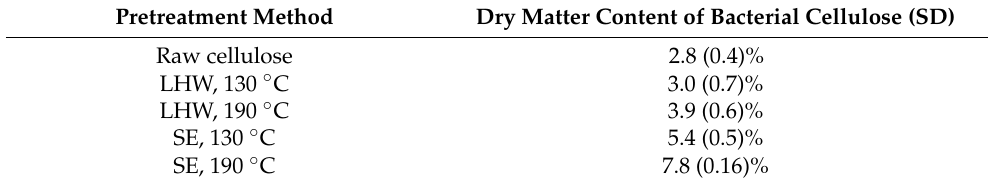
Table 2. Properties of the treated bacterial cellulose.